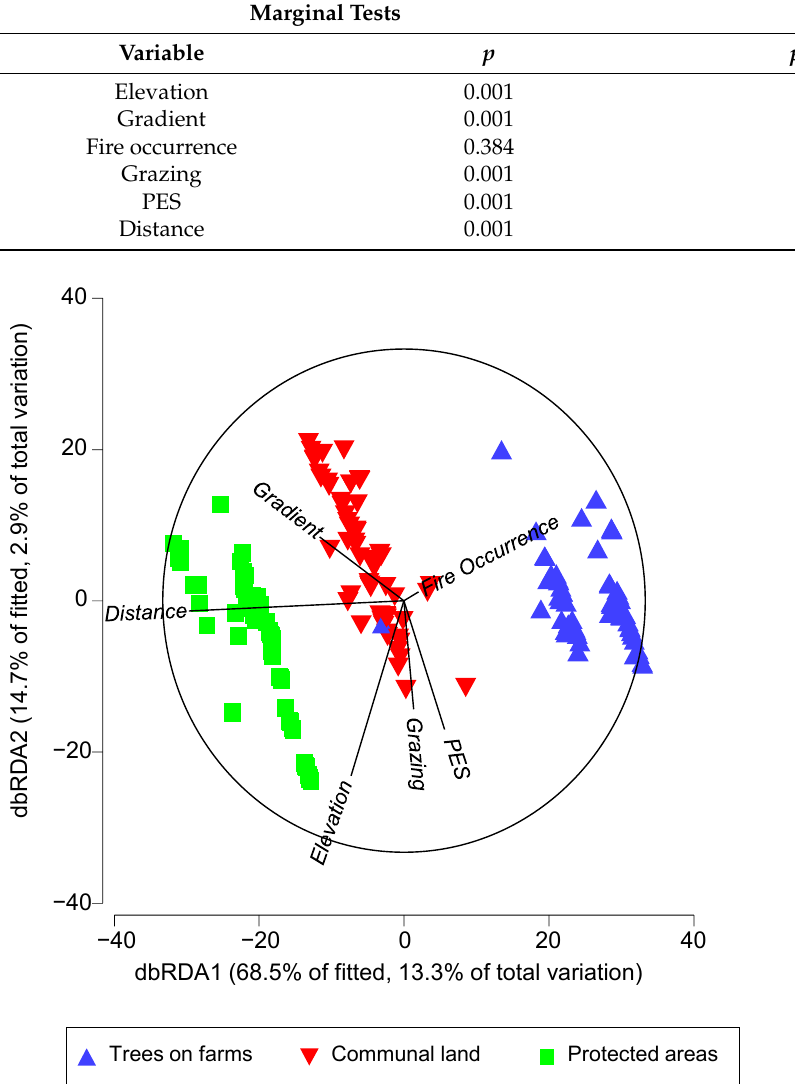
Figure 5. dbRDA (distance-based redundancy analysis) on the association of land-uses and other environmental factors in the study areas.